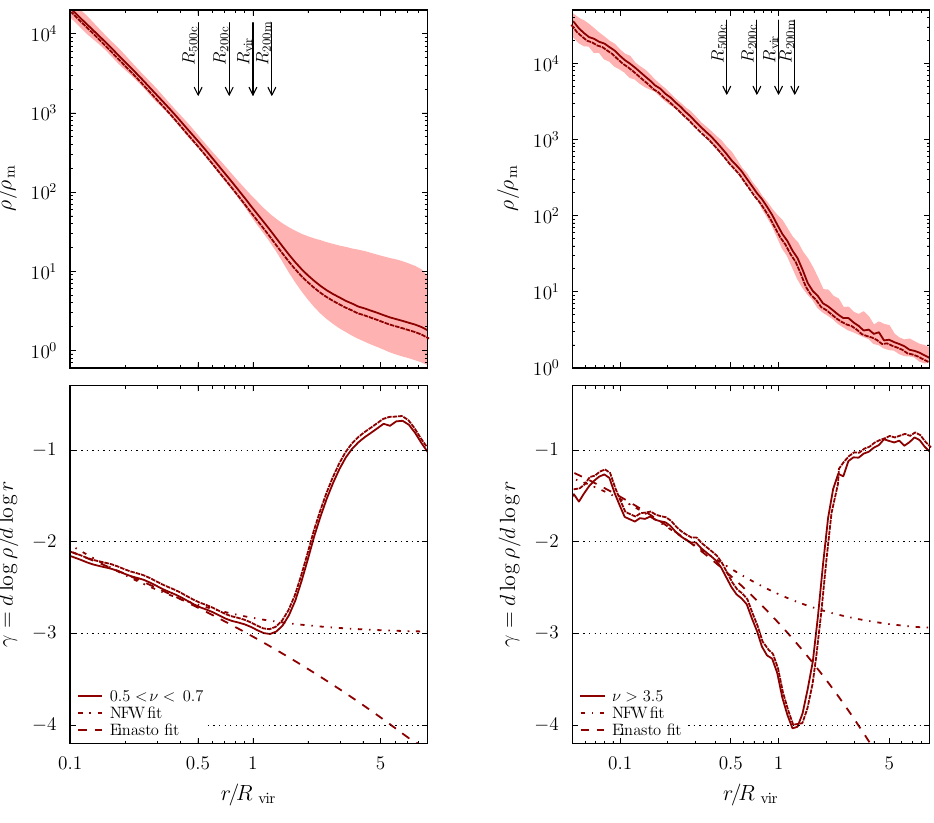
Figure 1. Median density profiles of low-mass ( top left ) and very massive haloes ( top right ) at z = 0. The shaded band represents the interval around the median containing 68% of the profiles of individual halos in the ν bin. The bottom panel shows the logarithmic slope profiles from the top panel profiles. The NFW and Einasto fits of the profiles are indicated as well. The solid lines represent the results from [19]. The dotted lines in the top panels represent the median density profiles, while the bottom panels show the logarithmic slope profile, both obtained with our